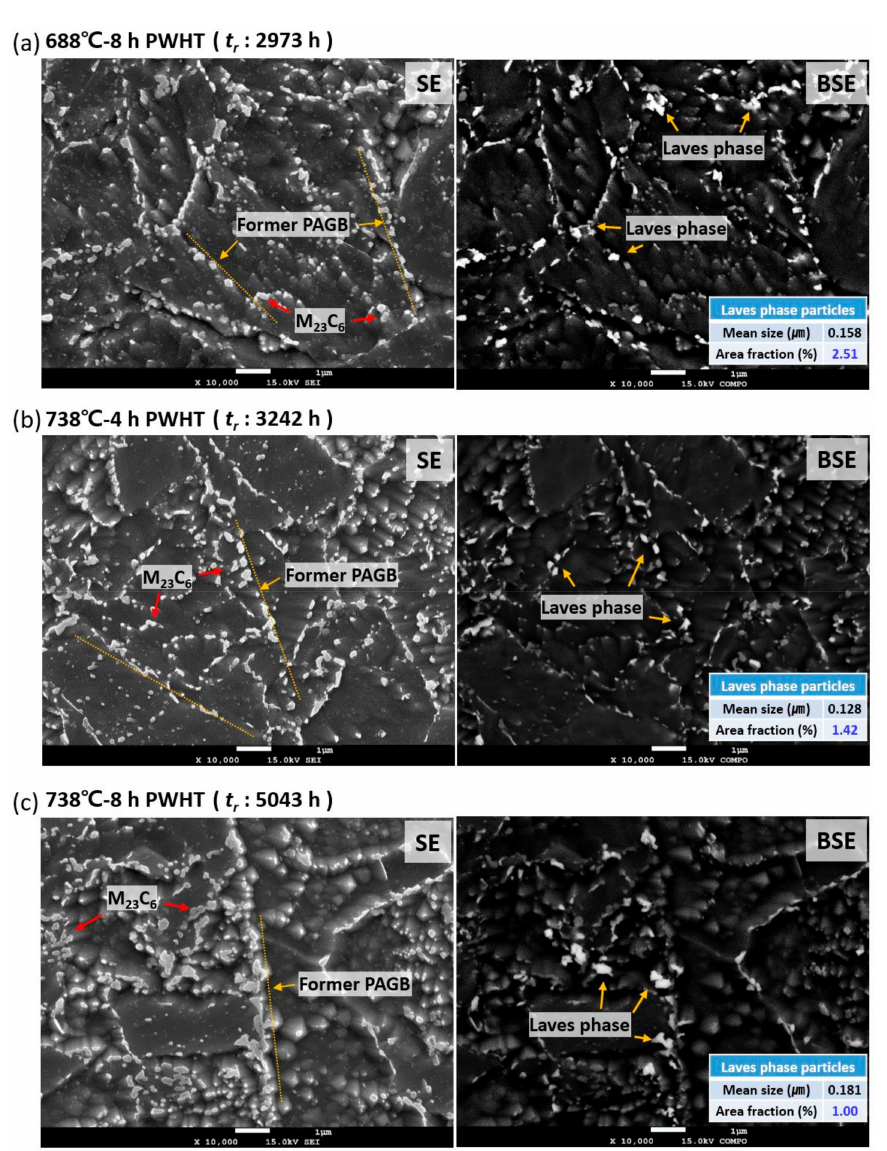
Figure 9. SEM and corresponding BSE images of the ICHAZ after creep test (including mean particle size and area percentage of the Laves phase particles): ( a ) 688 ◦ C-8 h; ( b ) 738 ◦ C-4 h; and ( c ) 738 ◦ C-8 h PWHTed specimens.